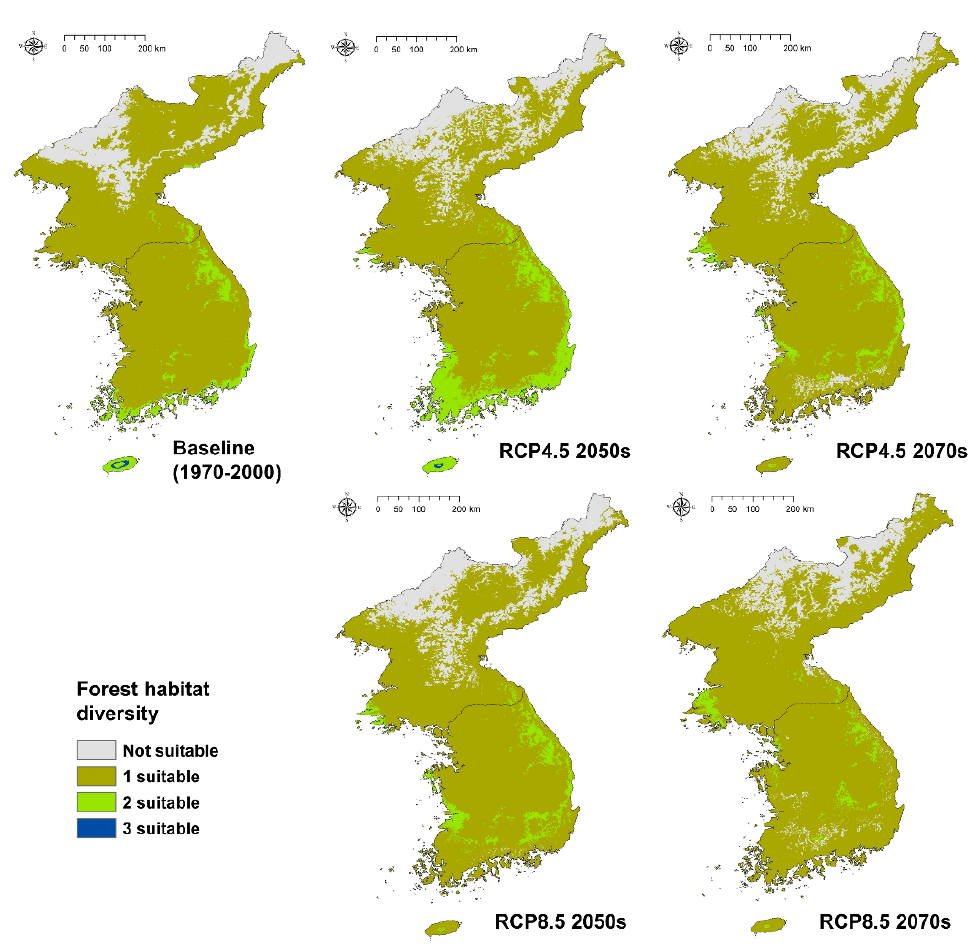
Figure 7. Spatial distribution of forest habitat diversity in baseline and future climates.